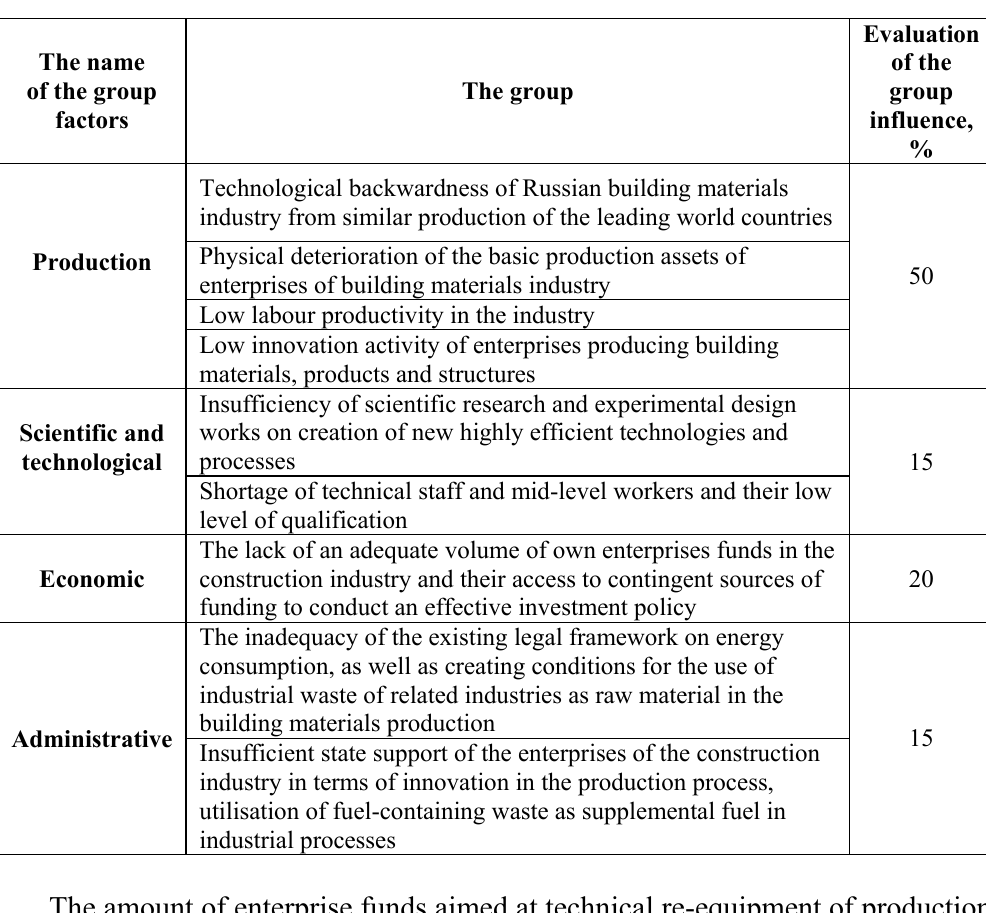
Table 2. Factors of the High Energy Consumption in the